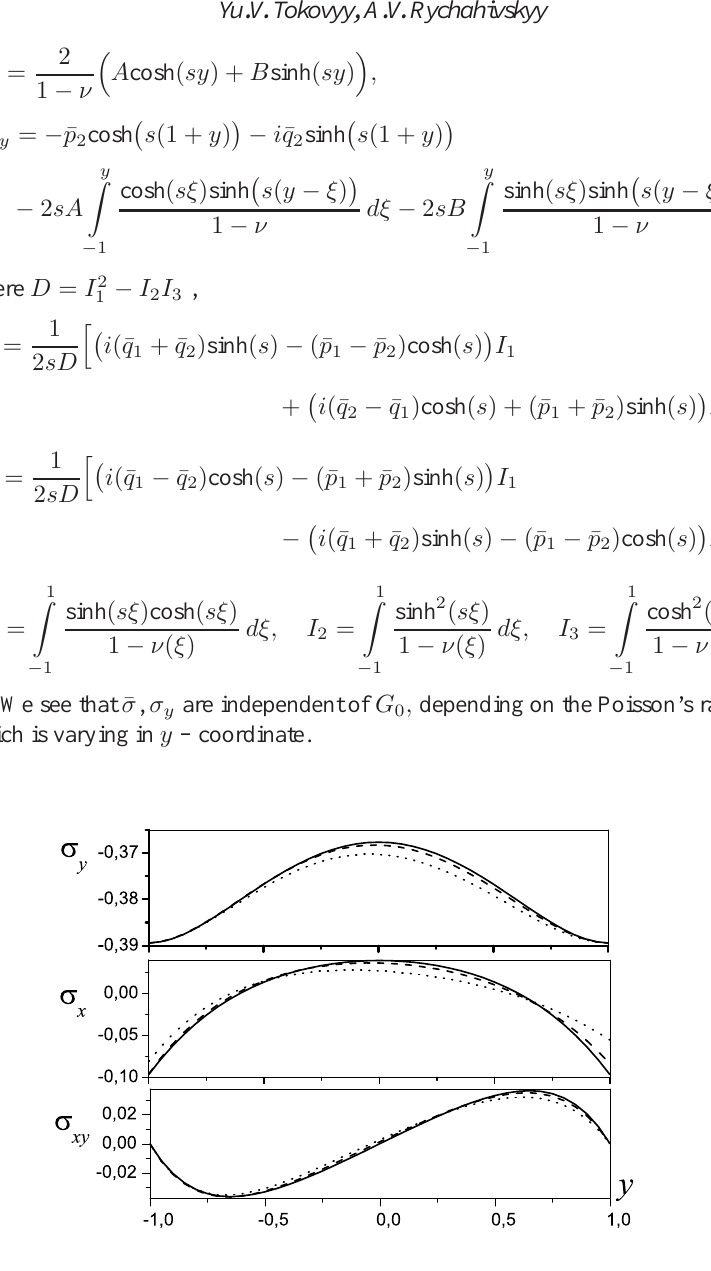
Figure 1. y -dependence of dimensionless stresses in D at x = 0 . 5 (solid line – a = 0, dashed line – a = 0.5, dotted line – a =